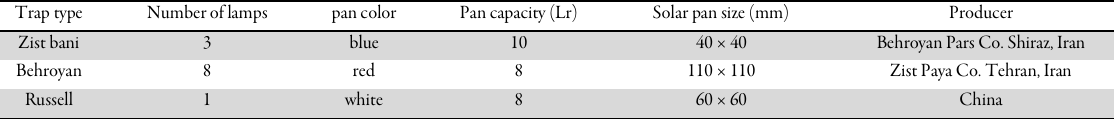
Table 1. The relevant characters of light traps used for mass trapping of Tuta absoluta in the